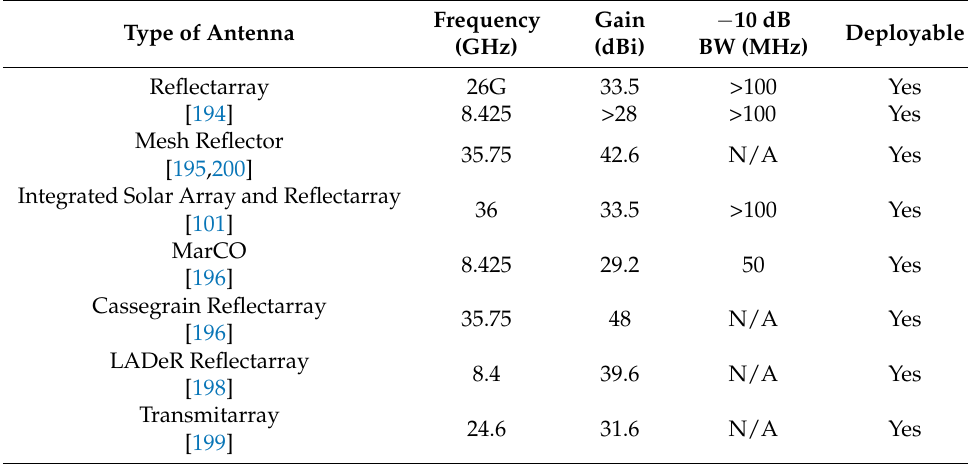
Table 13. Performance of reflectors, reflectarrays, and